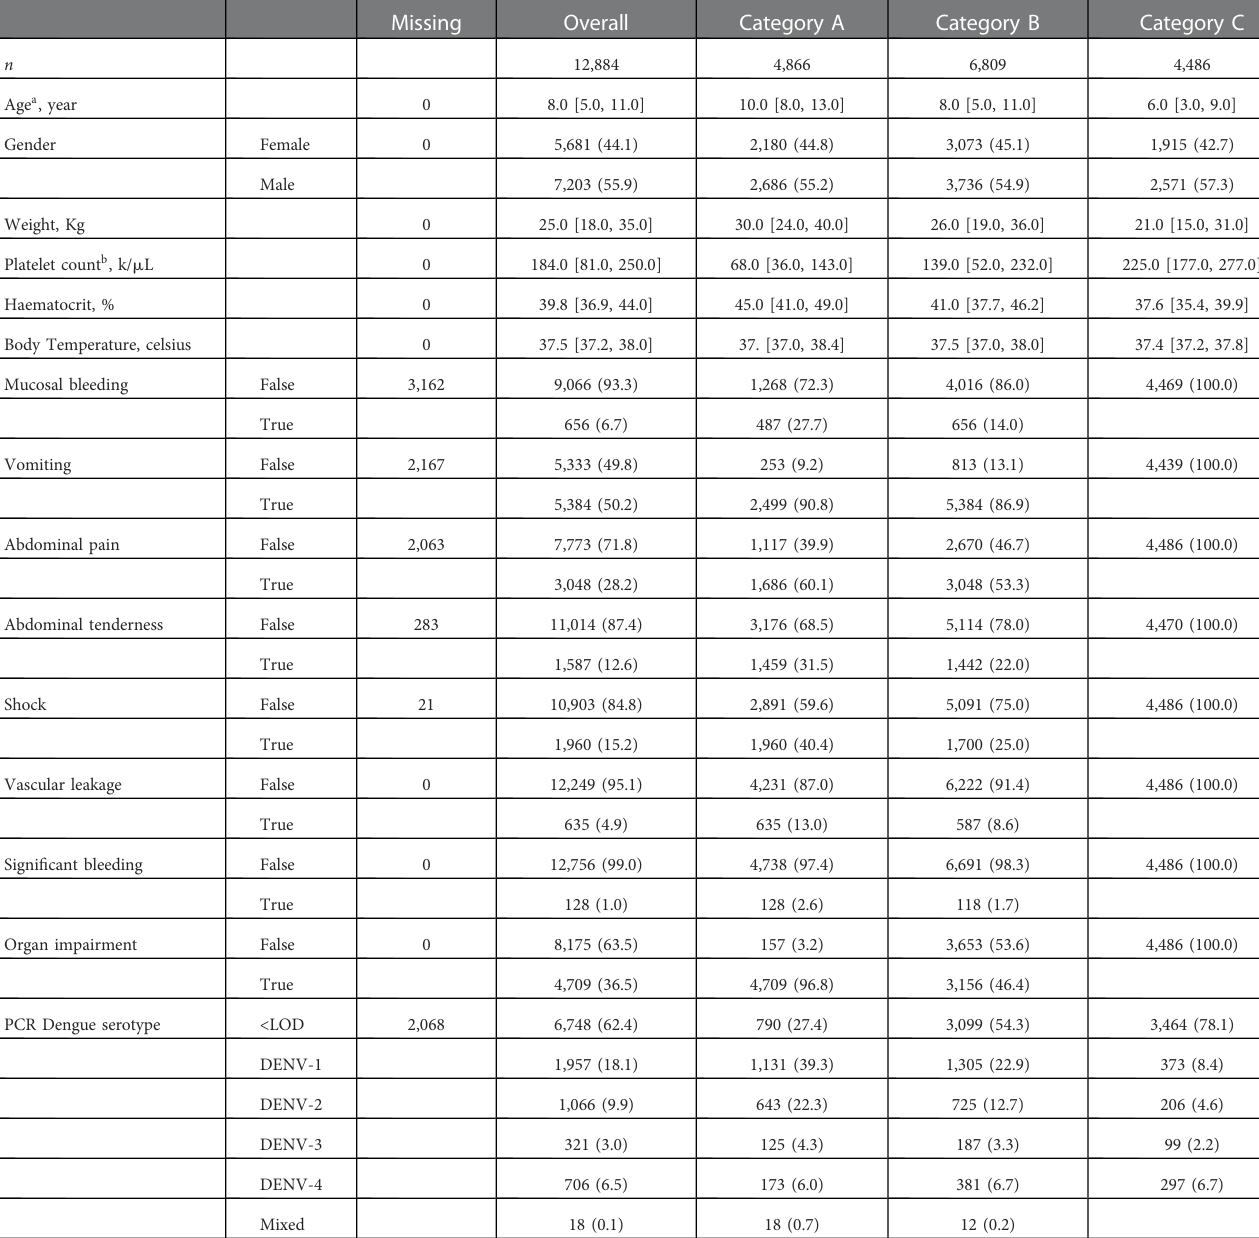
TABLE 6 Characteristics of patients for the overall worst patient status data and categories A, B and